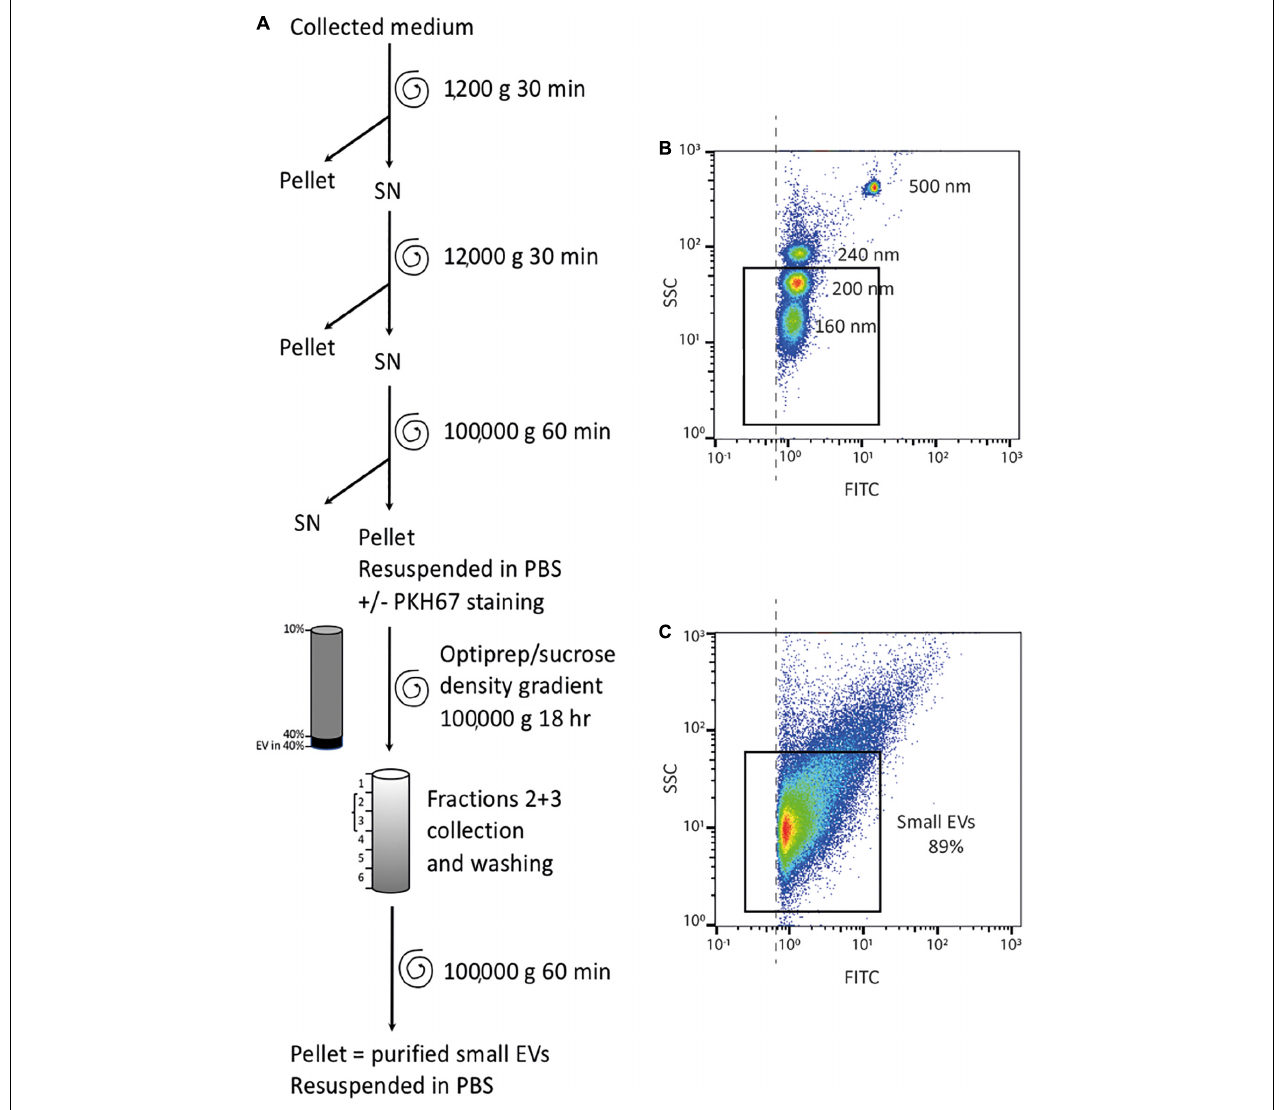
FIGURE 2 | sEV preparation pipeline and flow cytometry analysis. (A) Pipeline of sEV preparation using medium collected from placental histocultures. (B) Flow cytometry standardization on fluorescent-FITC beads (160 nm, 200 nm, 240 nm, and 500 nm). Each population size was defined on SSC granularity and FITC fluorescence parameters. The black rectangle indicates the gating strategy on small bead populations (160 nm and 200 nm). The dashed line represents the threshold for the detection of sEVs. (C) Representative analysis of one placental sEV preparation gated on small events as described above. In this example, 89% of events were below 200